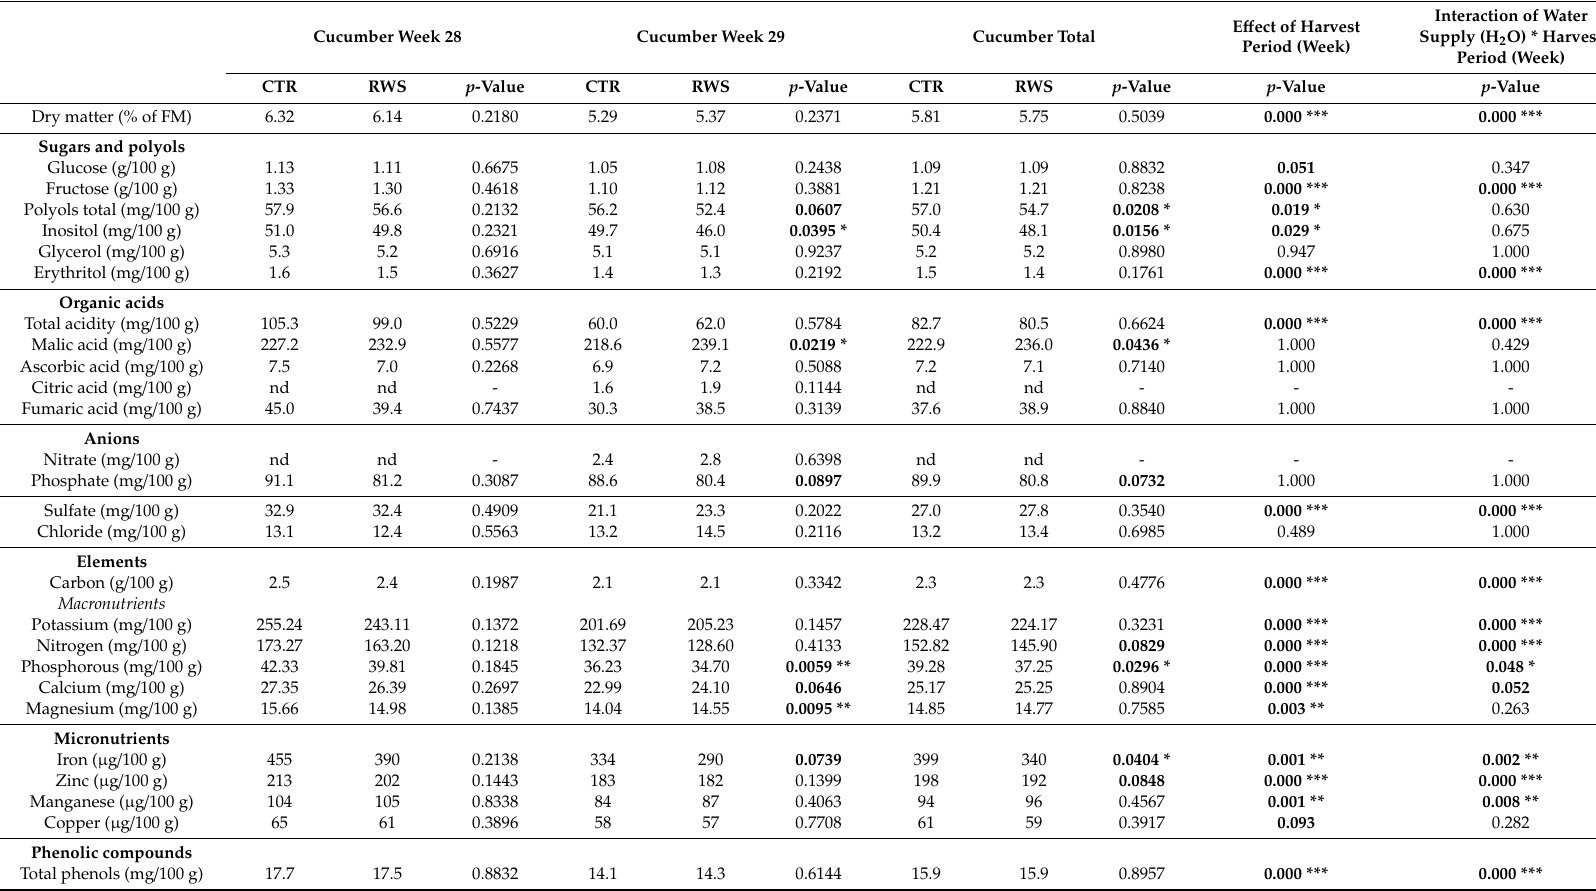
Table 3. Influence of moderate water reduction on the fresh matter (FM)-related levels of constituents of cucumber fruits from two harvesting sets (week 28 and week 29) in 2016. Linear mixed model, t-test, p -values: < 0.1, < 0.05 (*), < 0.01 (**) and < 0.001 (***); nd = not determined, CTR: Control treatment with full water supply, RWS: Reduced water supply